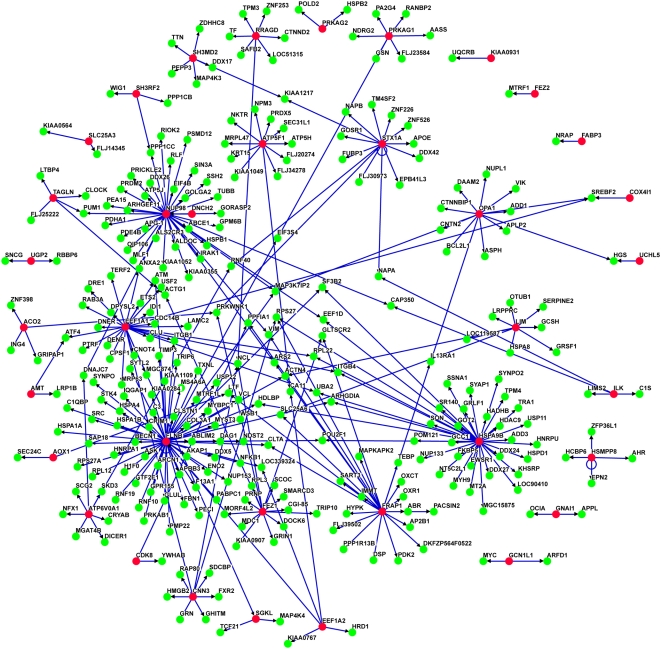
Subset of Longevity Network including only those genes whose expression is significantly changed in young vs old human muscle.Longevity gene homologs are shown in red; interacting proteins are shown in green. The network contains 339 interactions among 325 proteins.